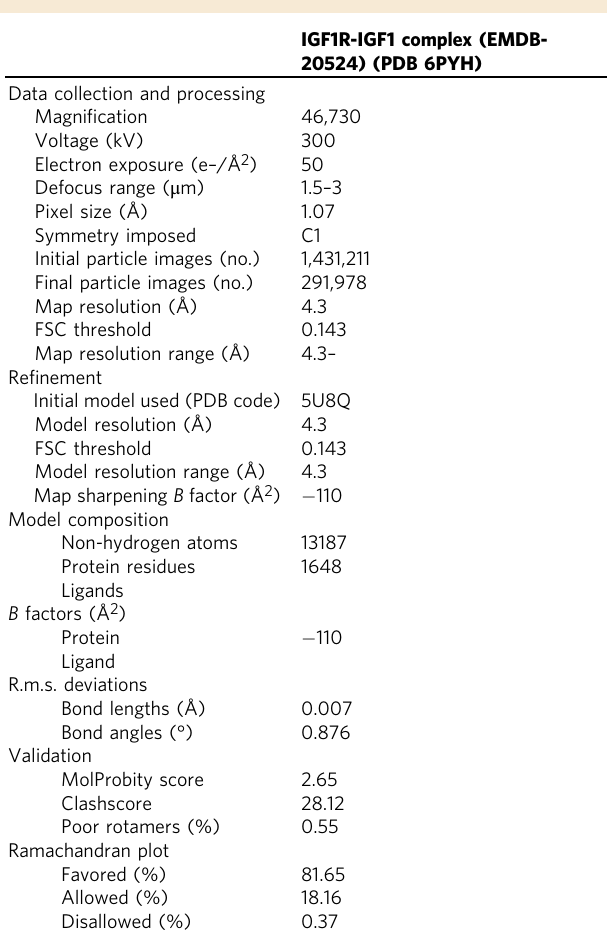
Table 1 Cryo-EM data collection, re fi nement, and validation